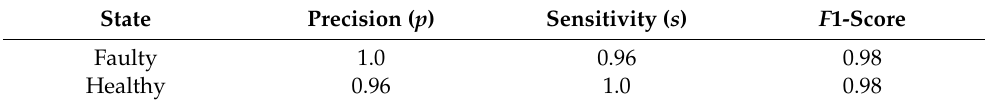
Table 3. Performance metrics for the proposed TL-based model for fault detection using simple motion.